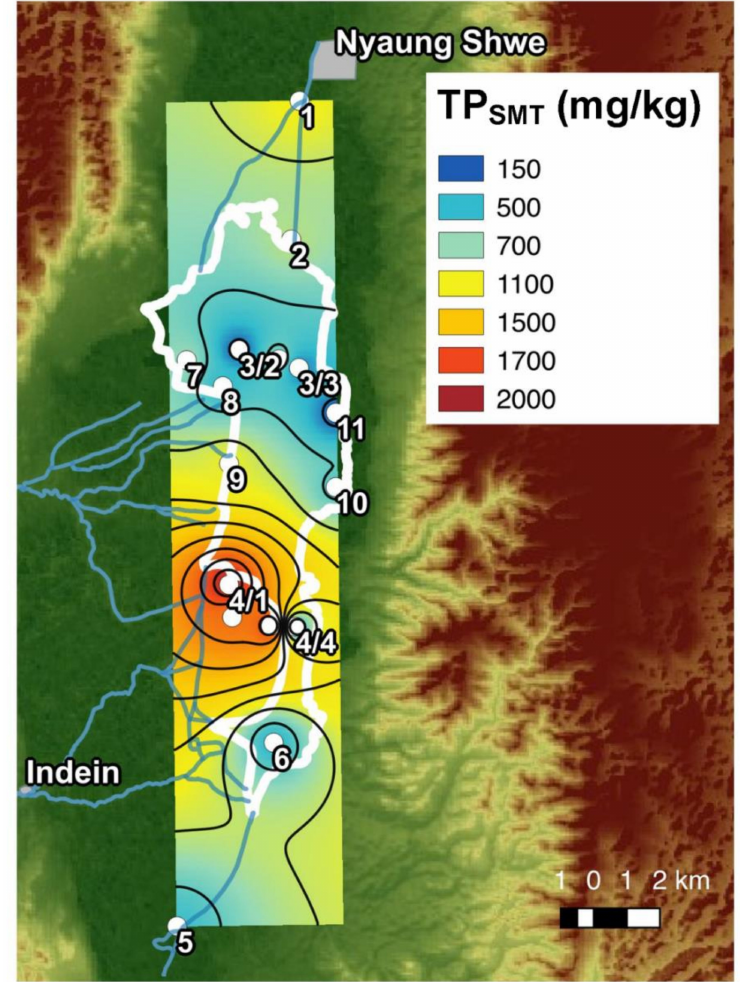
Figure 5. Spatial interpolation (inverse squared distance method) of TP SMT data from grab